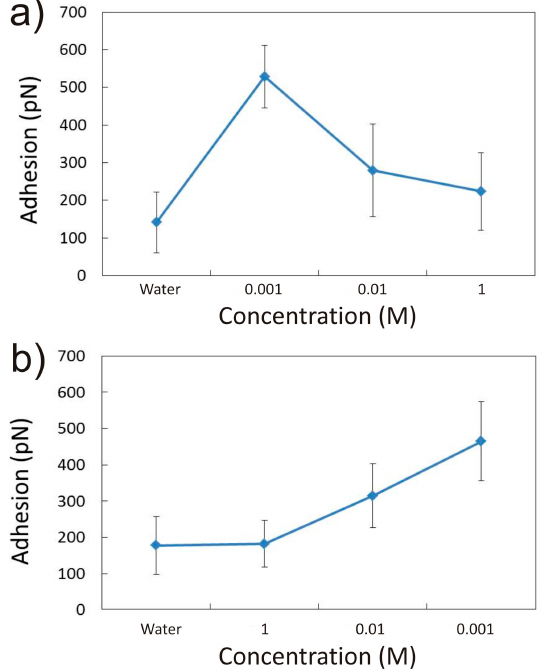
Figure 3. Graphs showing the measured adhesion for experiments kao-Si-1 ( a ) and kao-Si-2 ( b ) performed with a –COOH probe over the siloxane surface of kaolinite and in the presence of CaCl 2 solutions of different concentrations (0.001, 0.01 and 1 M) at pH ≈ 5.5. ( a ) the solutions were introduced in the fluid cell following a sequence of low to high CaCl 2 concentration; ( b ) the solutions were introduced in the fluid cell following a sequence of high to low CaCl 2 concentration. In both experiments, an increase in the adhesion with lower CaCl 2 concentration is observed.